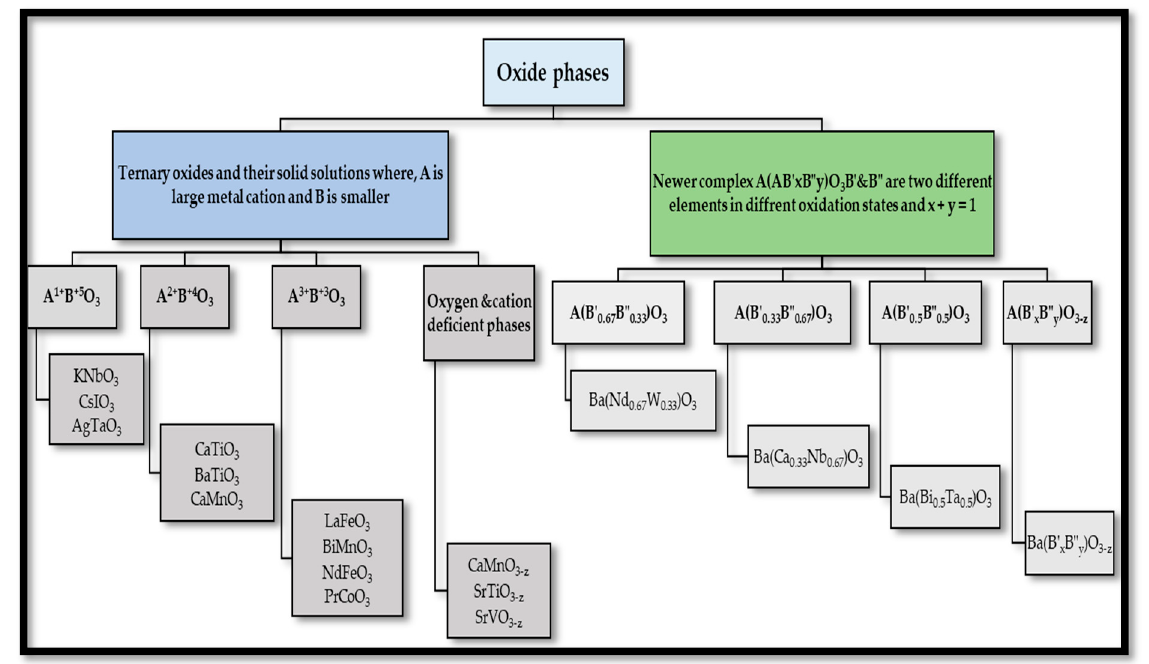
Figure 7. Classification of perovskite structures (Reprinted with permission from [5]).